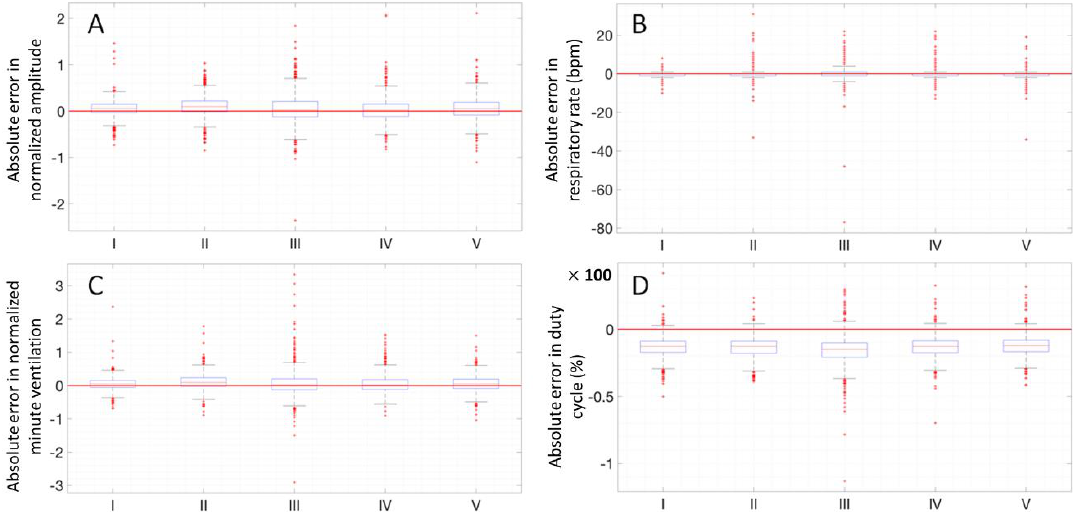
Figure 11. Absolute error box plots, all subjects, different intensities during exercise, all parameters: normalized amplitude ( A ), respiratory rate ( B ), normalized minute ventilation ( C ) and duty cycle ( D ). The intensities shown are the following: low (L), medium (M), high (H), maximum (IMAX), recovery phase 1 (RP1), recovery phase 2 (RP2). 3.4. Bland–Altman Plots The Bland–Altman plot allows us to appreciate how much the system being validated differs from the reference system. The results obtained in the case of a healthy female subject (38 years old, 166 cm, 52 kg; same subject shown in Figures 6, 7 and 9) are reported in Figure 12 in the case of exercise and recovery tests for normalized ventilation and respiratory rate parameters. The obtained results are not significantly different from the results obtained in the previously illustrated representation methods. Focusing on normalized ventilation (Figure 12, left), points tended to decrease with increasing ventilation, thus displaying the behavior of a proportional error. Respiratory rate (Figure 12, right) showed a constant variability of the error.